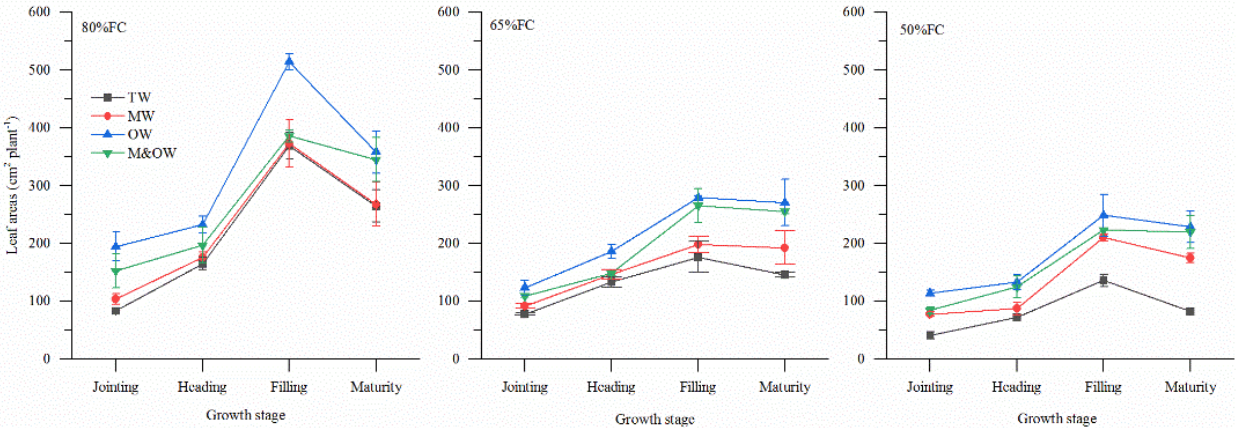
Figure 3. Effect of tap water (TW), magnetized water (MW), oxygenated water (OW), and magnetized and oxygenated water (M&OW) irrigation on total leaf area per plant of winter wheat with 80%FC, 65%FC, and 50%FC irrigation amount in the different growth stages. The error bars indicate standard deviations.